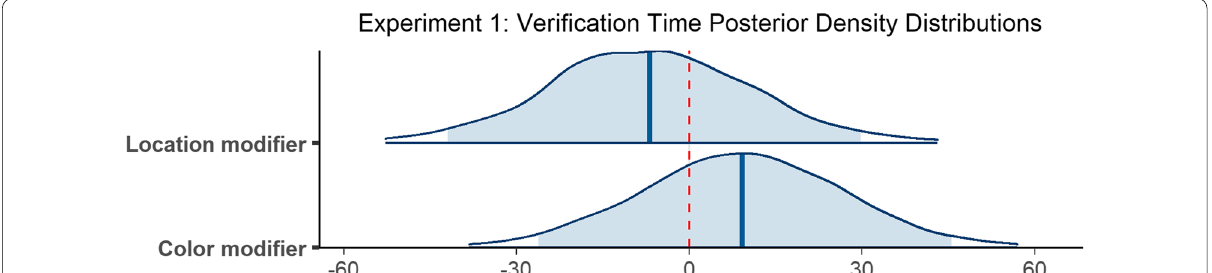
Fig. 6 Posterior density distributions for verification time β parameter estimates for each level of the fixed effect relative to the reference level. Light blue shaded regions indicate the 95% credible interval and blue vertical lines indicate the mean of the distribution. The red vertical dashed line highlights 0 on the x axis. If the red line falls within the light blue shaded region, the estimate is not reliably different from zero and interpreted as a null